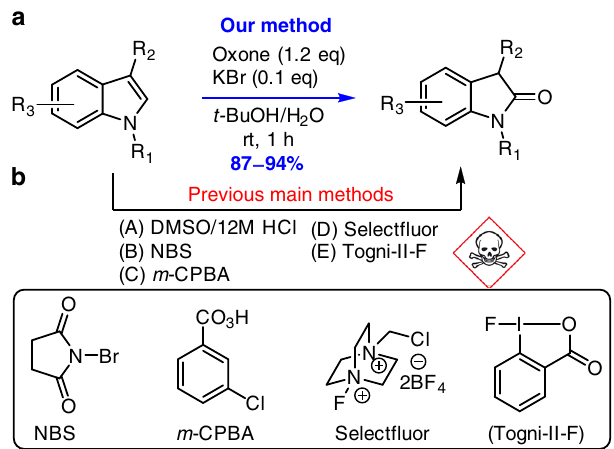
Fig. 4 Oxidation of indoles to 2-oxindoles. a Our method for oxidation of indoles to 2-oxindoles. b Previous methods for oxidation of indoles to 2-oxindoles